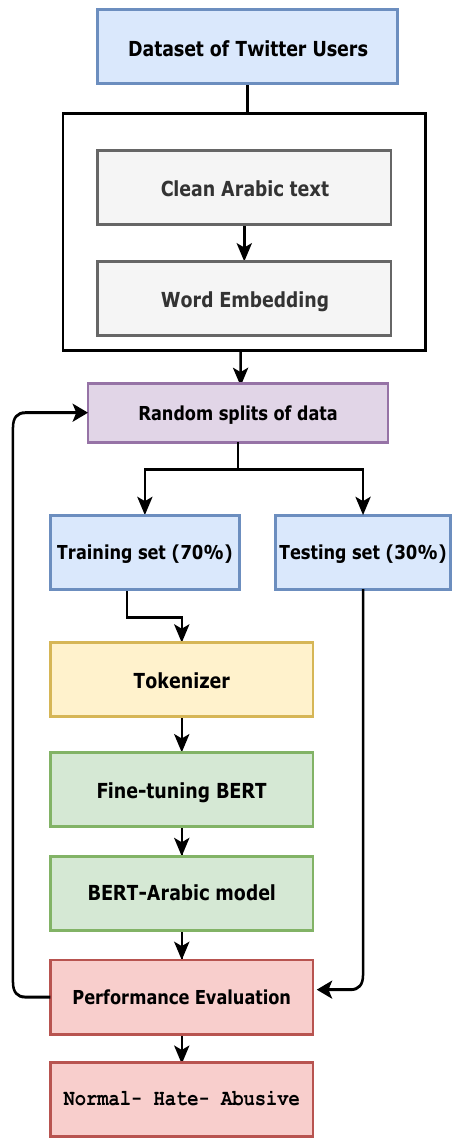
Figure 1. Architecture of the proposed